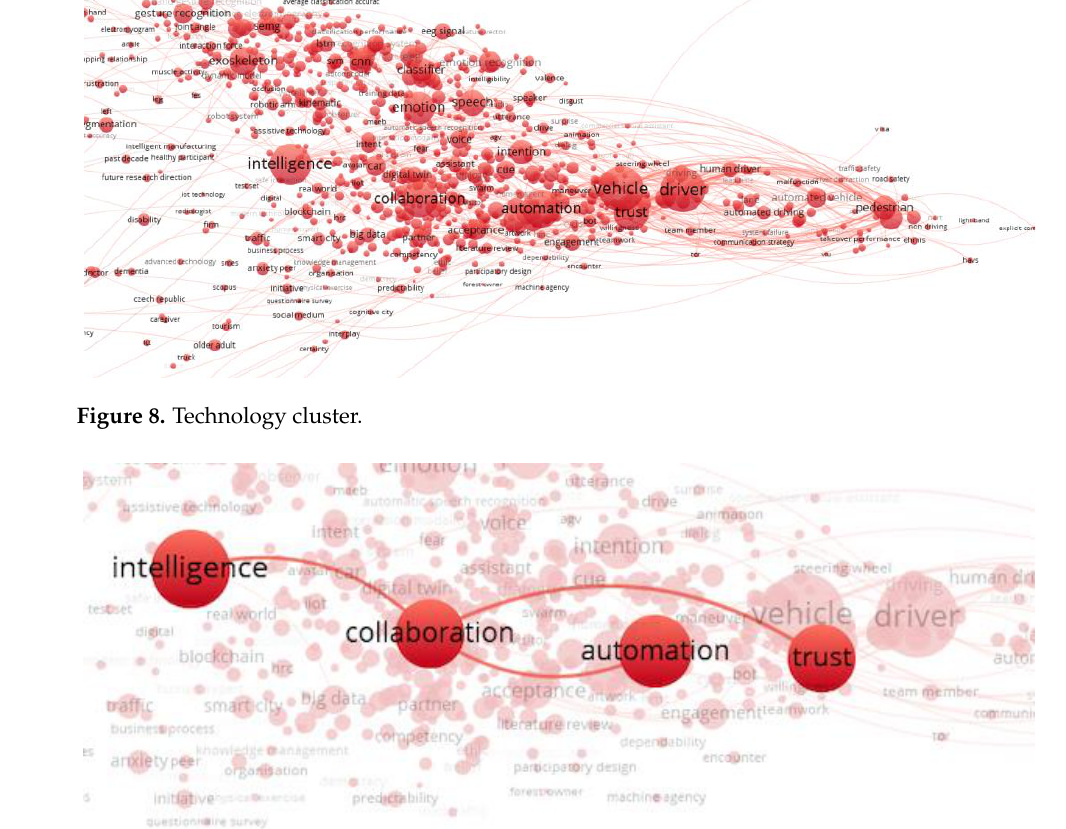
Figure 9. Collaboration dependency.